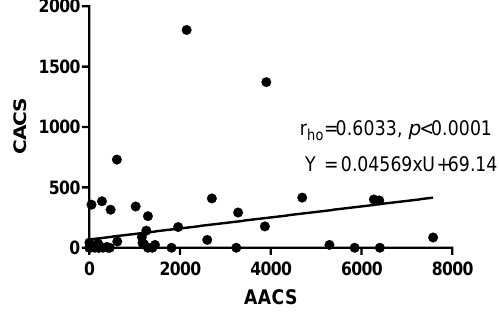
Figure 6. Spearman correlation between CACS and AACS.